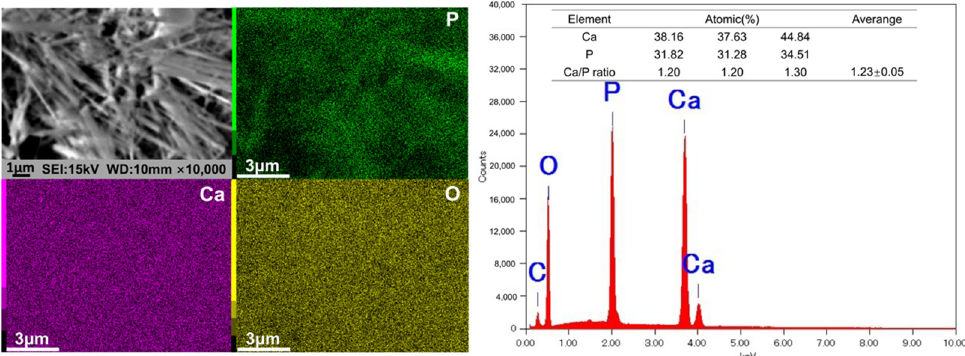
Figure 5. Energy-dispersive X-ray spectroscopy and elemental mapping (Ca, P, O) of the HA-Ti discs.